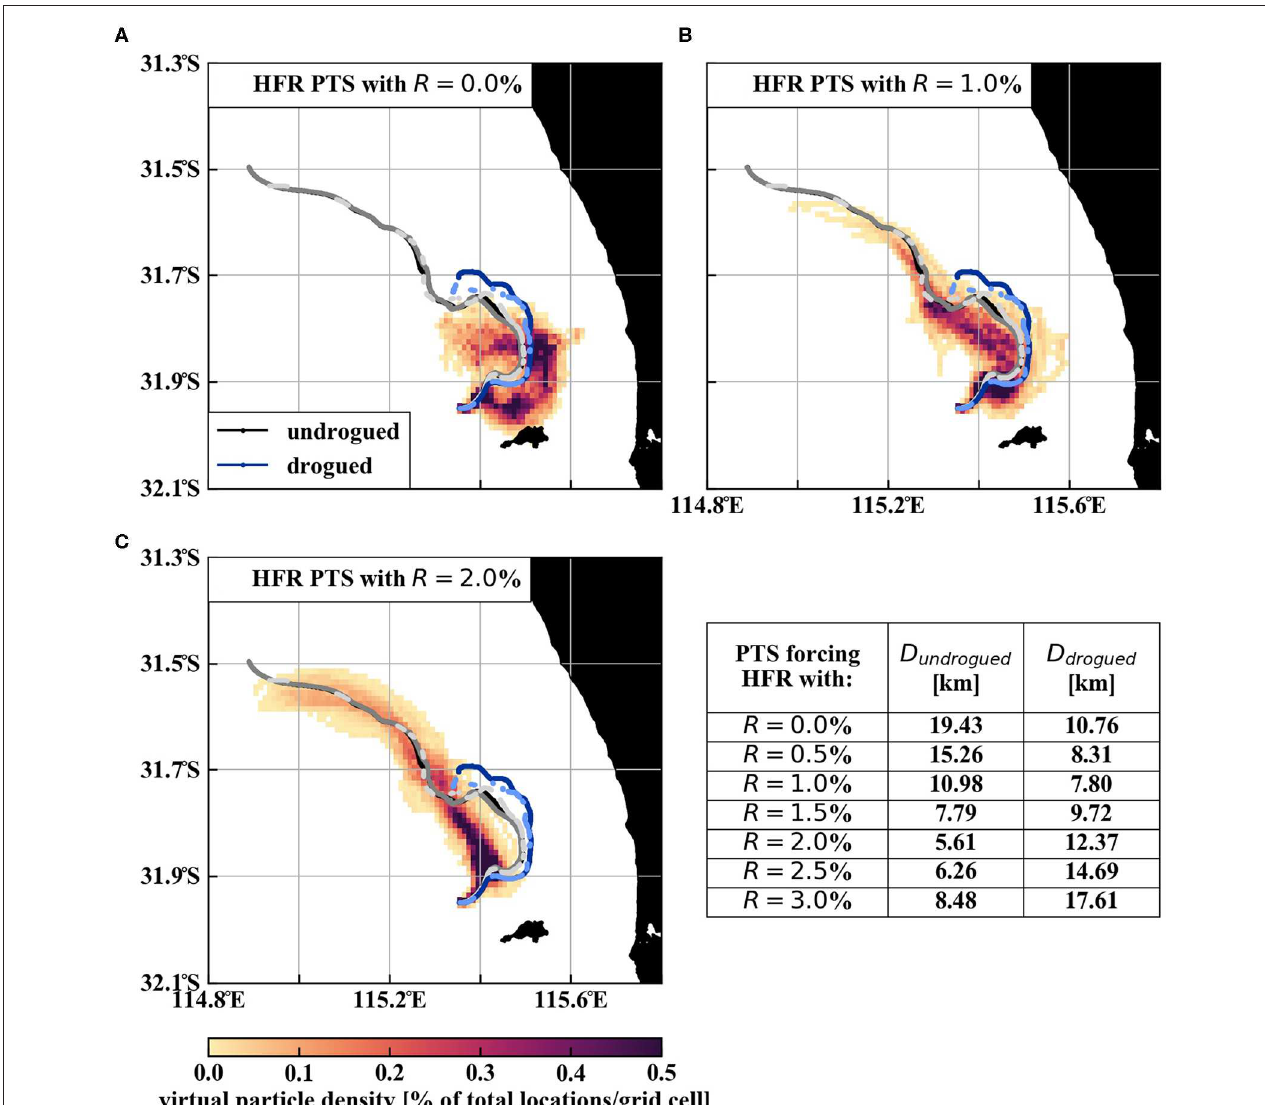
FIGURE 4 | Particle density (percentage of particle locations per 0.01 × 0.01 ◦ grid cells) of 100 simulated virtual particles, until 5 days after release at the drifter deployment location. Particles are advected by HFR measured current fields with a drift current factor of: (A) R = 0.0; (B) R = 0.01 = 1.0 % ; (C) R = 0.02 = 2 % ; and include Brownian motion with constant horizontal diffusion coefficient K h = 10.0. The trajectories of the undrogued (gray shades) and drogued (blue shades) drifters for 5 days after their release are also shown. (Table) Mean cumulative separation distance D between all 100 simulated virtual particles and an undrogued and drogued drifter for 5 days for simulations with different values for the drift